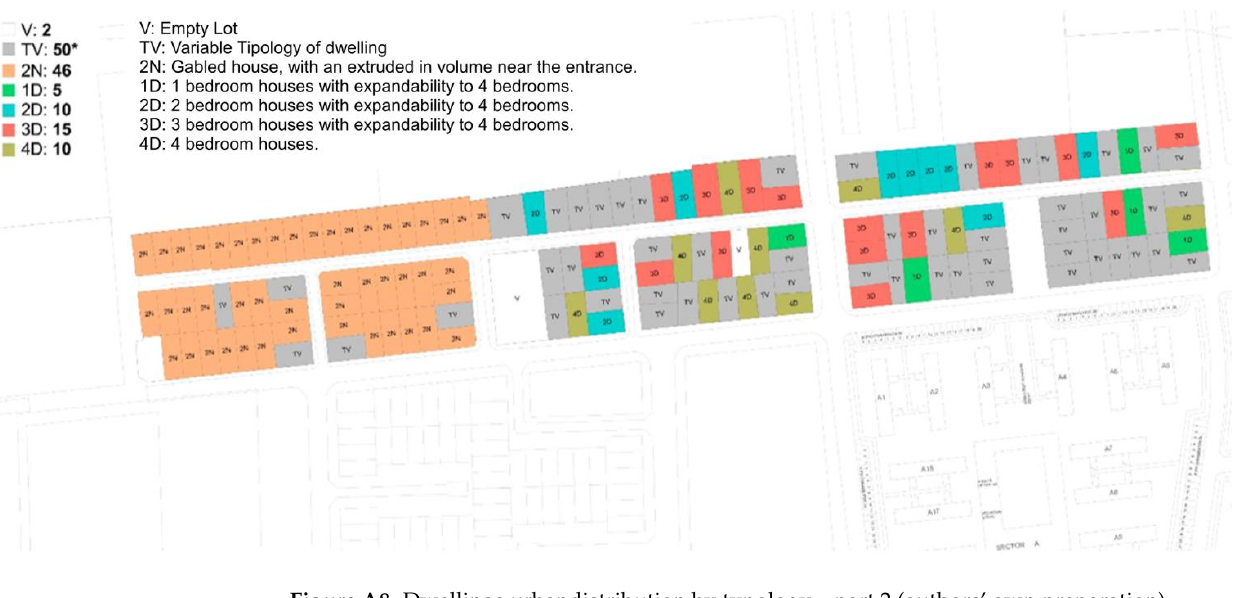
Table A3. Loads for devices, lighting, occupation, ventilation, and slogans for simulations.